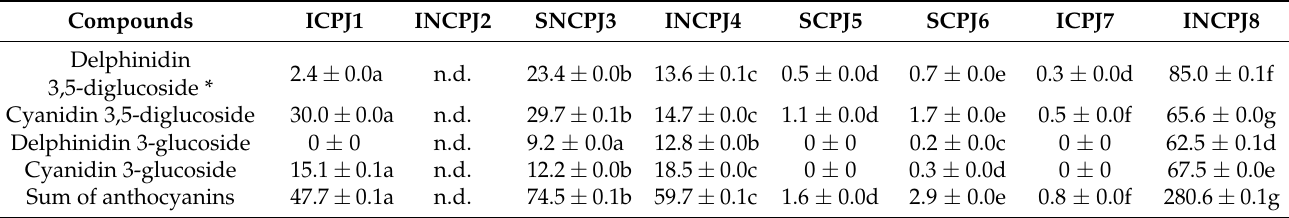
Table 4. Anthocyanins (mg/L) of